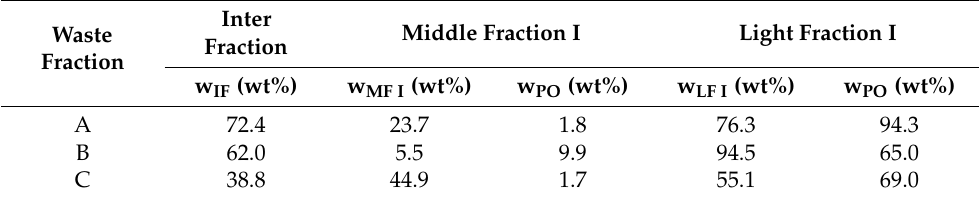
Table 13. Mass fraction of the inter (w IF ), first middle (w MF I ) and first light fraction (w LF I ) and corresponding polyolefin fraction(w PO ) of the first CFS for feedstocks with high (A), middle (B), and low (C) initial polyolefin share.